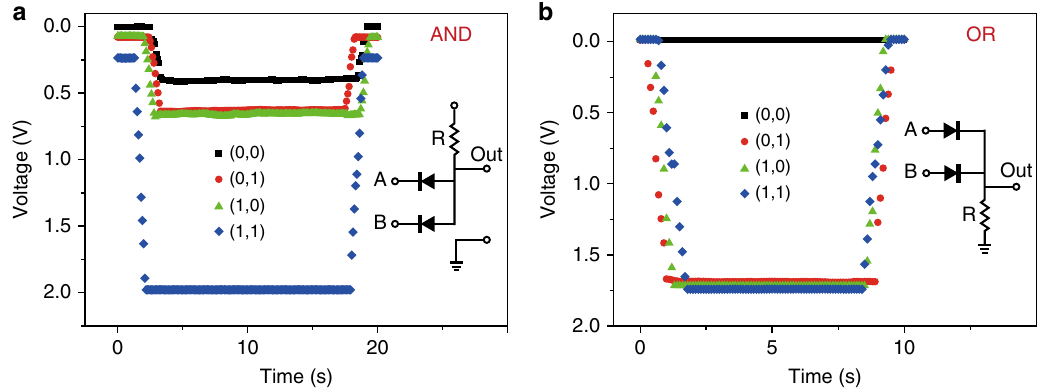
Fig. 4 All carbon materials circuits based on graphene pn diode. a , b Demonstration of an AND logic gate ( a ) and an OR logic gate ( b ) fabricated by integrating graphene pn diodes and resistors. The inset is the circuit diagram. An input of 0 or 1 represents low (0 V) or high (2 V) potentials. For both gates, the resistance of the resistor is approximately 10 M